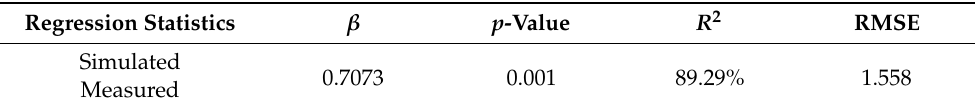
the electrical load on each day of the